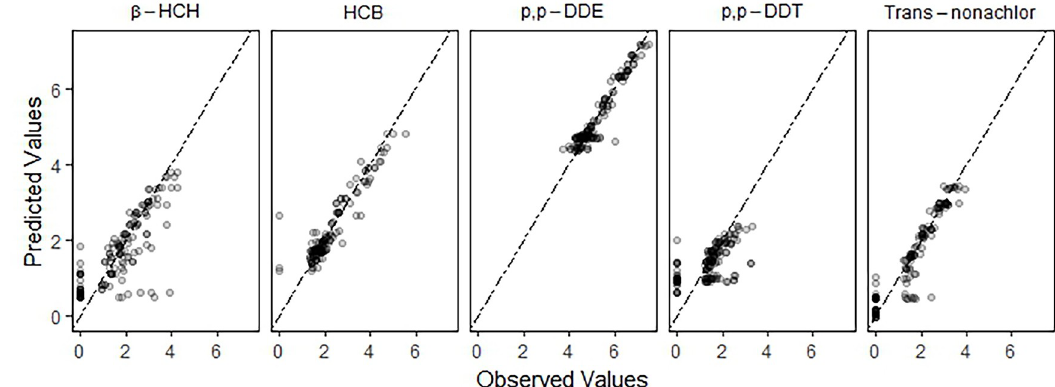
Fig 1. Graphical evaluation of BRT models for OCP concentrations. Graphical comparison of observed (horizontal axis) and predicted (vertical axis) log-transformed OCP concentrations to illustrate accuracy of BRT models for HCB, β -HCH, Trans- nonachlor, p,p’ -DDE and p,p’ -DDT concentrations. BRT models for HCB and p,p’ -DDE had more accurate predictions than models for β -HCH, Trans-nonachlor and p,p’ -DDT. All points in these plots have partial transparency so that a darker shade is indicative of overlapping points. Unit of OCP concentrations were in ng/g